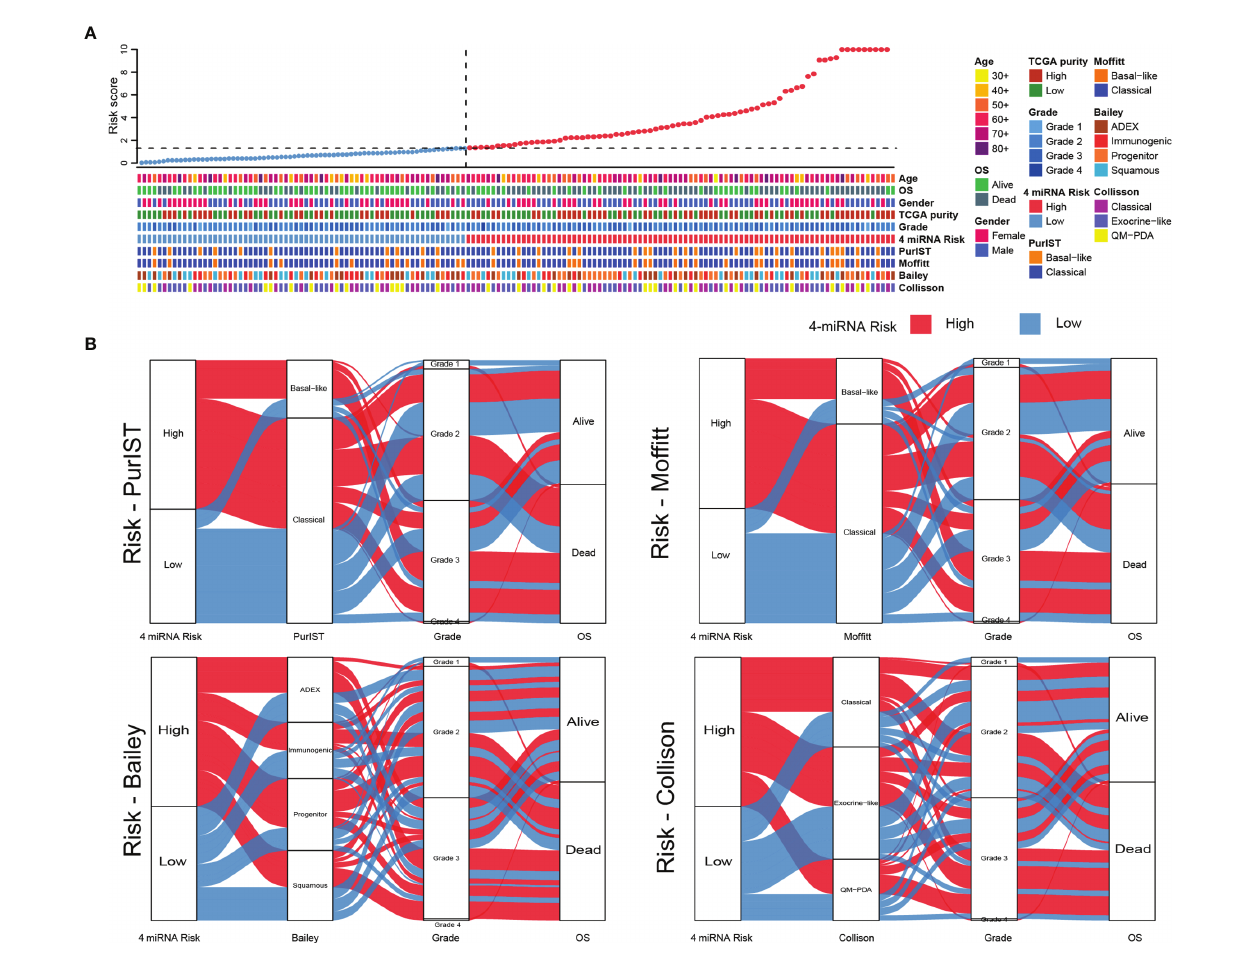
FIGURE 7 | The comparison of 4-miRNA risk groups to molecular subtypes of PAAD. (A) The heat map showed the classi fi cation results with various molecular subtype system in TCGA PAAD cohort. The upper panel showed the samples were sorted by the 4-miRNA risk scores and the lower panel showed the detail subtype information. (B) The Sankey diagrams showed the relationship of high and low risk groups to each of molecular subtyping systems (PurIST, Mof fi tt, Bailey,